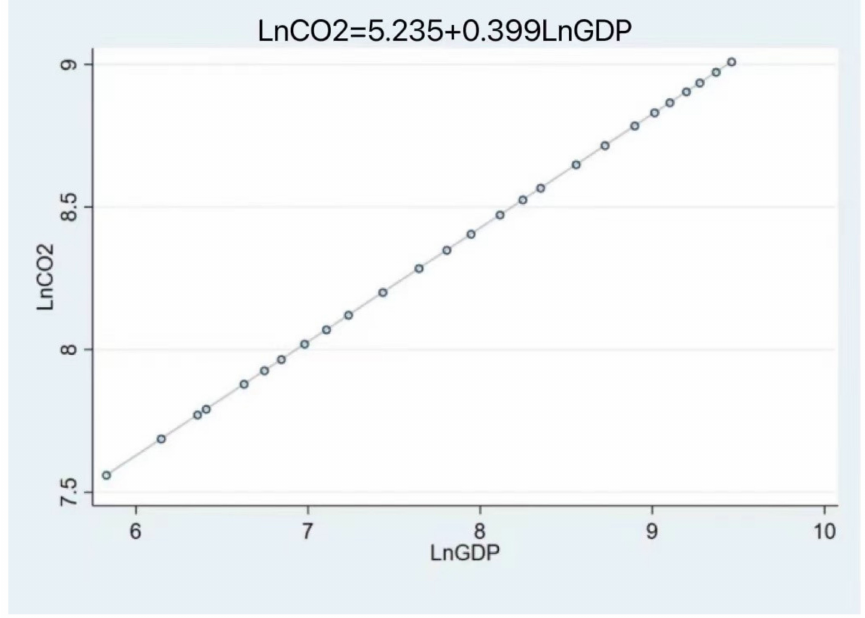
Figure 7. Equation